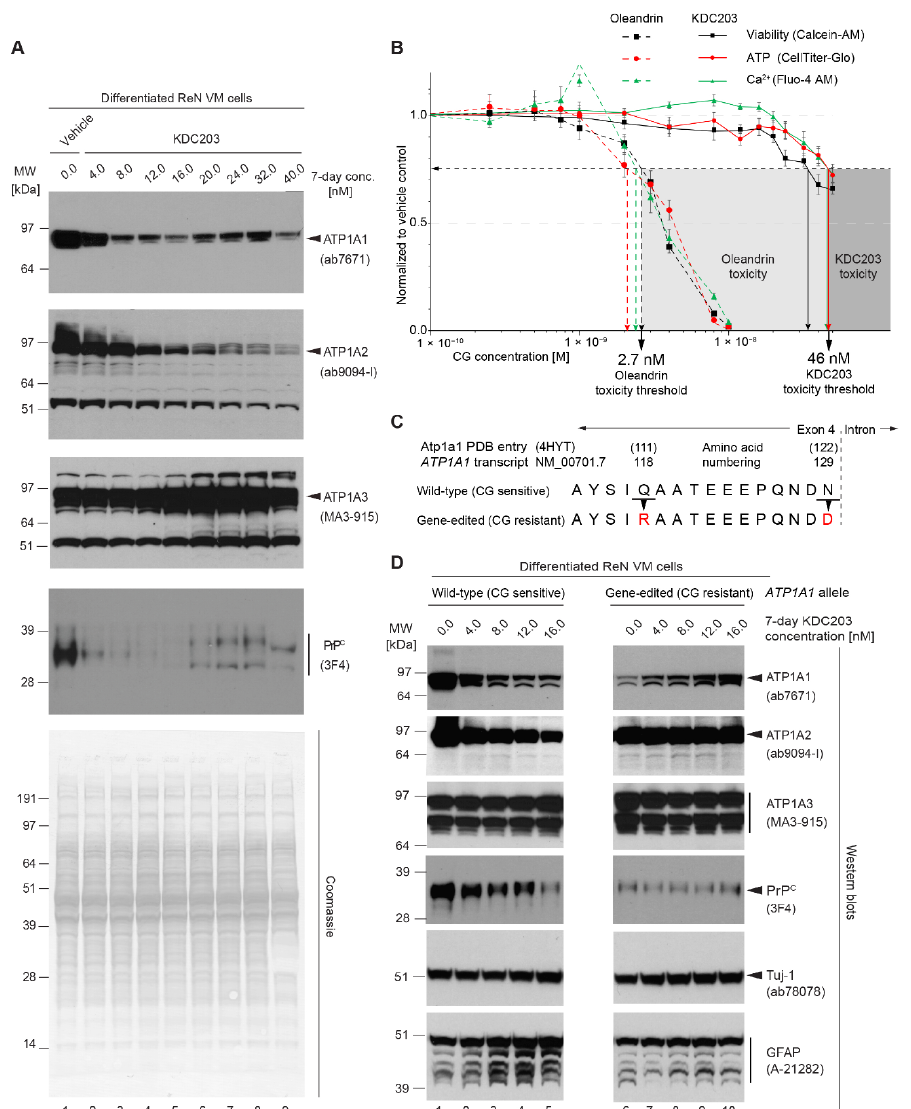
Figure 7. KDC203 induces a compensatory upregulation of ATP1A3, is less toxic than oleandrin, and requires binding to CG binding pocket within ATP1A1 for reducing PrP C levels. ( A ) The KDC203 concentration-dependent reduction in the steady-state protein levels of ATP1A1, ATP1A2, and PrP C is paralleled by an increase in ATP1A3 levels. Total concentrations of cellular extracts were adjusted, and equal volumes of these adjusted extracts were loaded onto the gel as evidenced by the Coomassie stain. Please note the slight rebound in ATP1A1 signals and the splitting of the 3F4-reactive signals into two bands that migrated slower and faster than the corresponding band in vehicle-treated differentiated ReN VM cells exposed to 20–32 nM KDC2039 concentrations. ( B ) KDC203 exhibits tenfold lower toxicity than oleandrin in three assays that were used to monitor the metabolic health of 7-day differentiated ReN VM cells. Each data point represents the mean of six biological replicates. Concentrations are depicted on a logarithmic axis. ( C ) Amino acid sequence alignment of an NKA α subunit segment contributing to CG binding in wild-type human ATP1A1 protein and its mutated derivative rendered refractory to CG binding by replacing human residues 118 and 129 (numbering based on human ATP1A1 transcript NM_00701.7) with the corresponding mouse Atp1a1 residues. ( D ) KDC203 causes the expected reduction in the steady-state levels of ATP1A1 and ATP1A2 in differentiated wild-type ReN VM cells but not in the gene-edited ReN VM ATP1A R/R cells whose ATP1A1 protein does not bind CGs. Despite the decrease in ATP1A2 levels, the NKA α subunit that is predominantly expressed in astrocytes, no reduction in the steady-state levels of astrocytic GFAP is